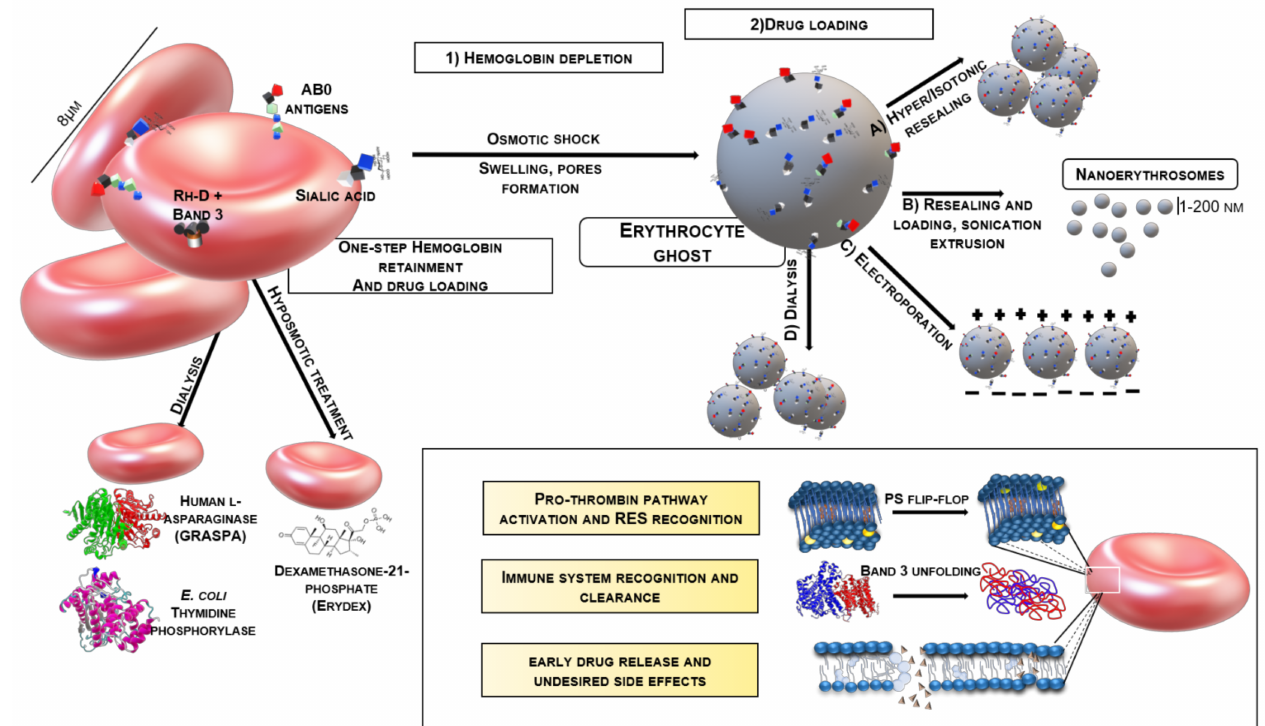
Figure 1. Summary of internal loading methods. Hb can be maintained or not according to the processing procedure and the identity of the cargo. In the inset the most important unwanted effects are shown. The explanation can be found in the text. PDB entries: Human L-Asparaginase 4O0H [113]; E. coli thymidine phosphorylase 4LHM [114]; Mouse Band 3 4YZF [88]. Models were created using VMD